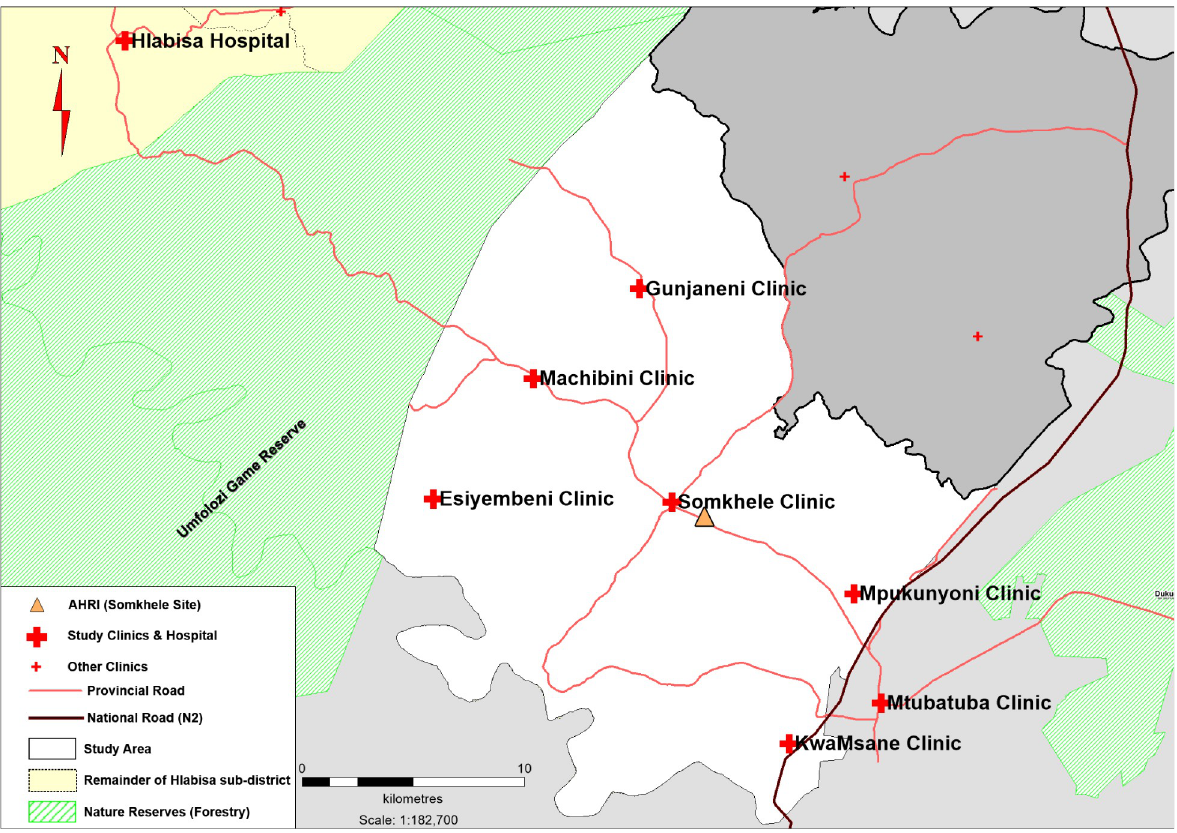
Fig 1. Participating study clinics located within AHRI PIPSA. The PIPSA is depicted in white and covers 438 km 2 . Primary care clinics and the local district hospital, Hlabisa Hospital, are marked with a red cross. Source credit : Sabelo Ntuli , AHRI Research Data Management . AHRI, Africa Health Research Institute; PIPSA, AHRI Population Intervention Platform Surveillance